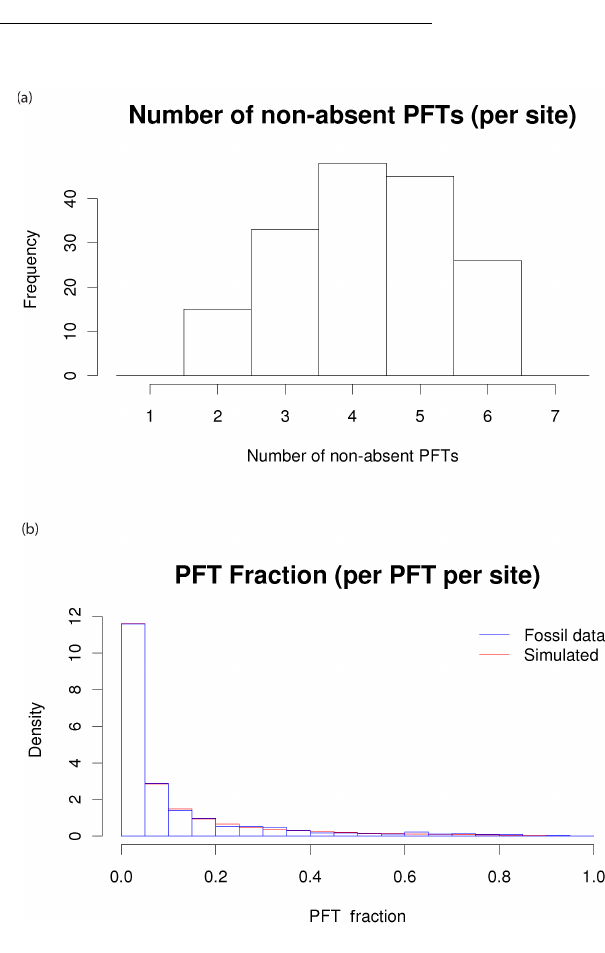
Figure E2. (a) Histogram of the number of non-absent PFTs (fossil diversity fraction>0.05) at fossil sites, and (b) histogram of the PFT diversity fractions per PFT per site across all sites, the blue line is from the actual fossil data, the red line is simulated for use in the models to estimate chance agreement, as discussed in the